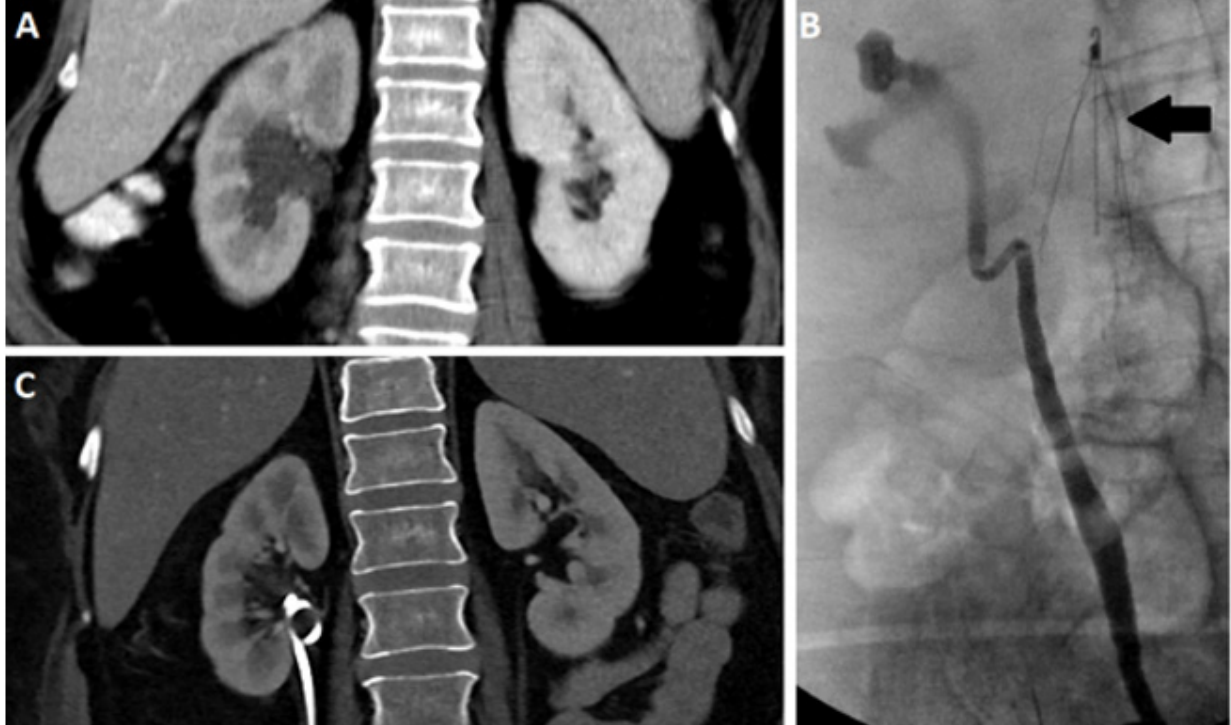
Figure 1. Coronal contrast enhanced CT ( A ) and retrograde pyelogram ( B ) depicting a hydronephrotic right kidney. Coronal CT after nephroureteral stent ( C ) placement demonstrating resolution of hydronephrosis. Note the presence of an IVC filter (arrow).